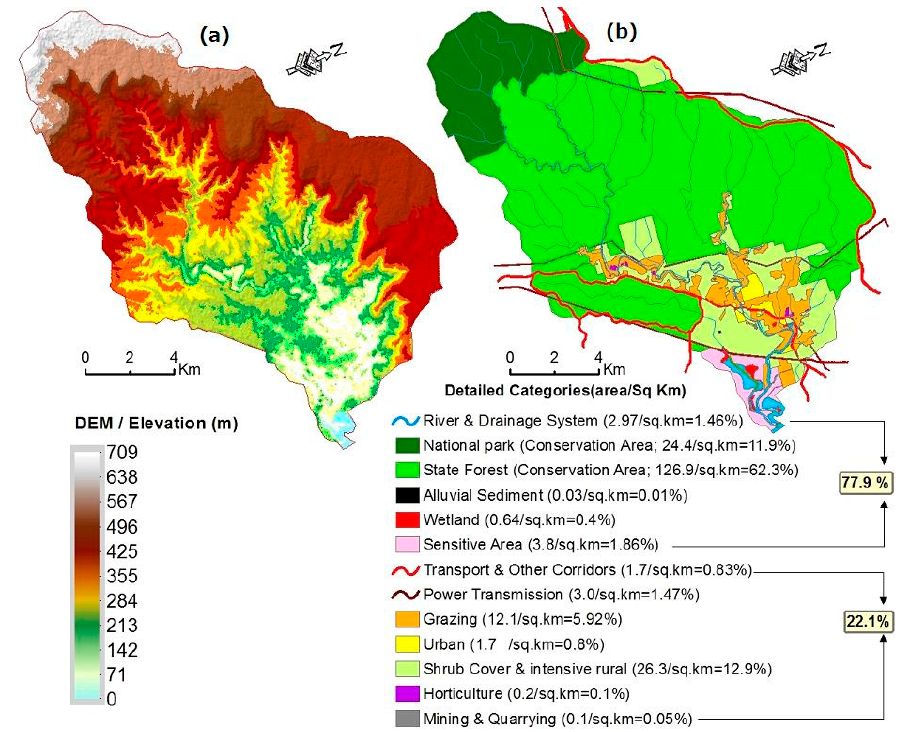
Figure 2. Landcover elevation and patterns within Wandandian Creek catchment area, showing; ( a ) the elevation of the catchment illustrating the terrain and high sloped watershed (using Australian height vertical datum at 1.024 m MSL), the 1-metre digital elevation model (DEM) is derived from C3 LiDAR (Light Detection and Ranging) obtained by LPI on 19 September 2016 [23]. ( b ) Land use classes and areas (km 2 ). Source after [15,17,18,23].